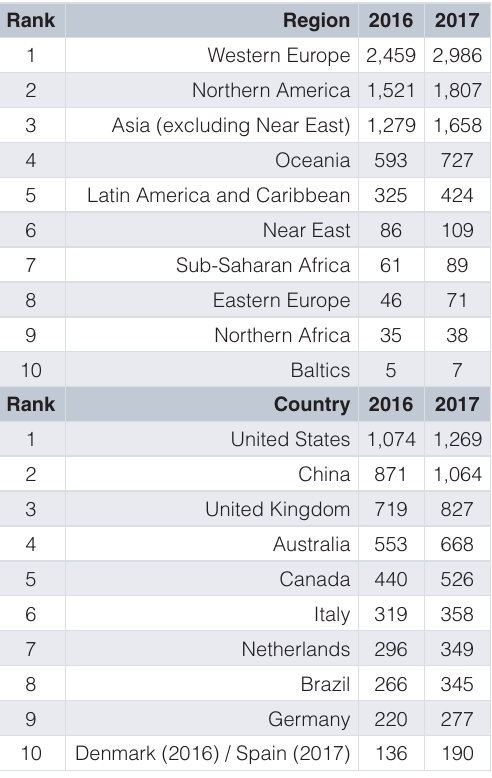
Table 2. Total good research practice scores for the top ten regions and countries in 2016 and 2017. These results exclude “Missing” as a nominal country or